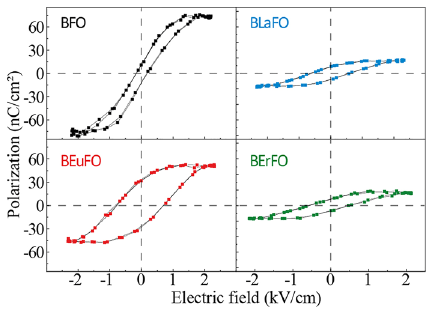
Figure 3. Room temperature ferroelectric (P-E) hysteresis loop of BFO, BLaFO, BEuFO, and BErFO samples.